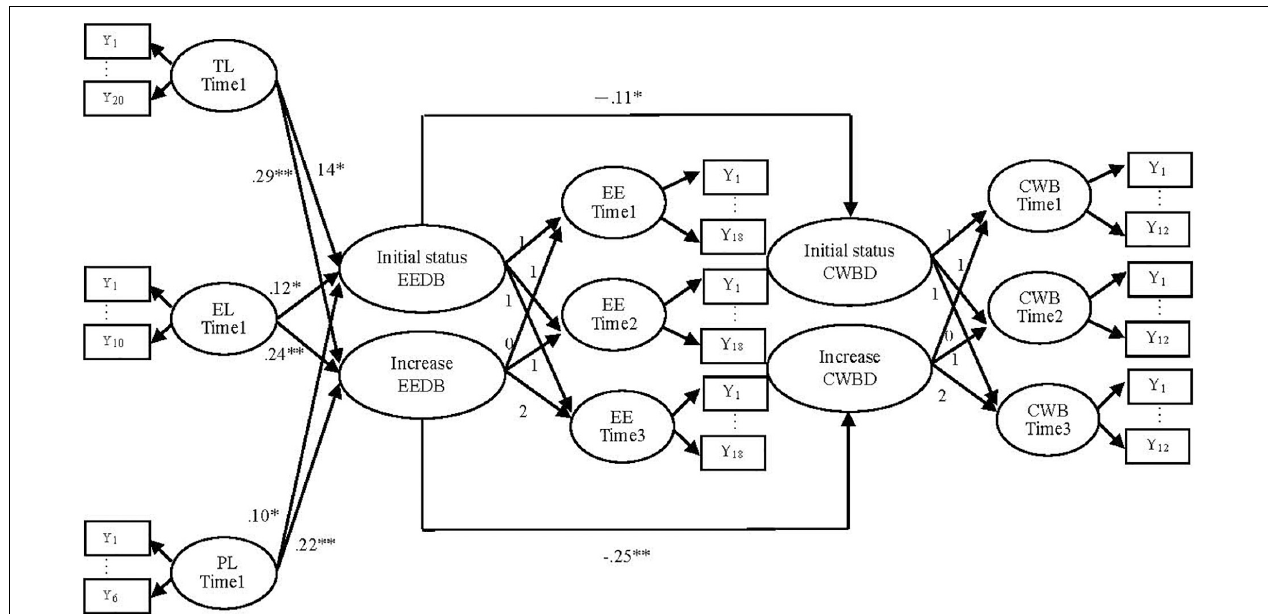
FIGURE 1 | The latent growth model of this study. TL, Transformational leadership; EL, Ethical Leadership; PL, Participative Leadership; EE, Employee Engagement; CWB, Counterproductive Work Behaviors; EED, Employee Engagement development; CWBD, Counterproductive Work Behaviors development; Y n , Measurement items. ∗ p < 0.05; ∗∗ p <